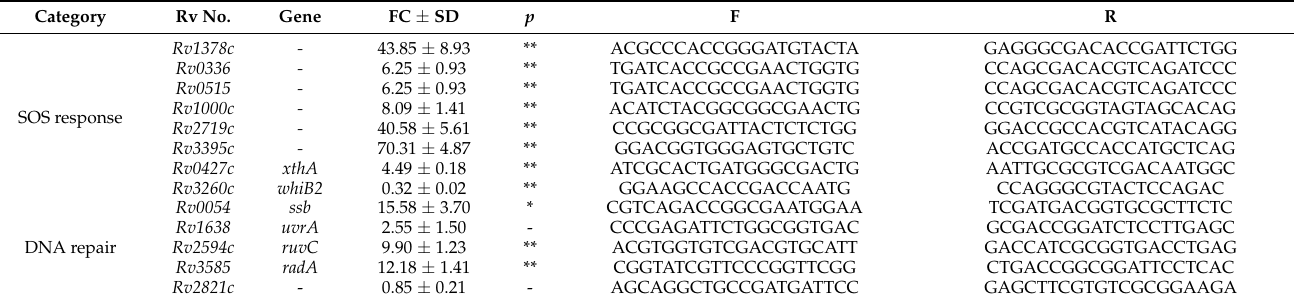
Table 1. mRNA fold-changes (FC) and standard deviations (SDs) determined by qRT-PCR for SOS response and DNA repair genes in aerobic Mtb H37Rv cells treated with 2 × MIC (0.25 µ g/mL) of MX for 16 h, compared to control cells grown in the absence of the drug F and R: forward and reverse primers, respectively (*), p < 0.02; (**), p < 0.002; (-), not significant. Category Rv